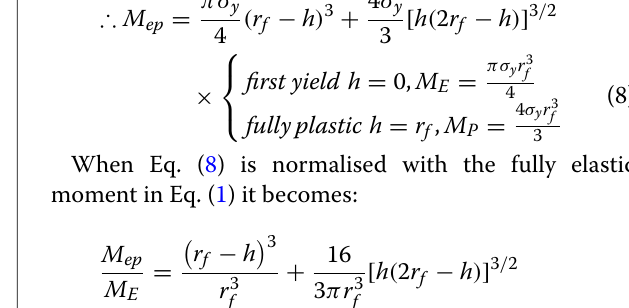
Fig. 6 Pull-out-slip curves of 3DH hooked-end steel fibres. a NSC, b MSC and c HSC